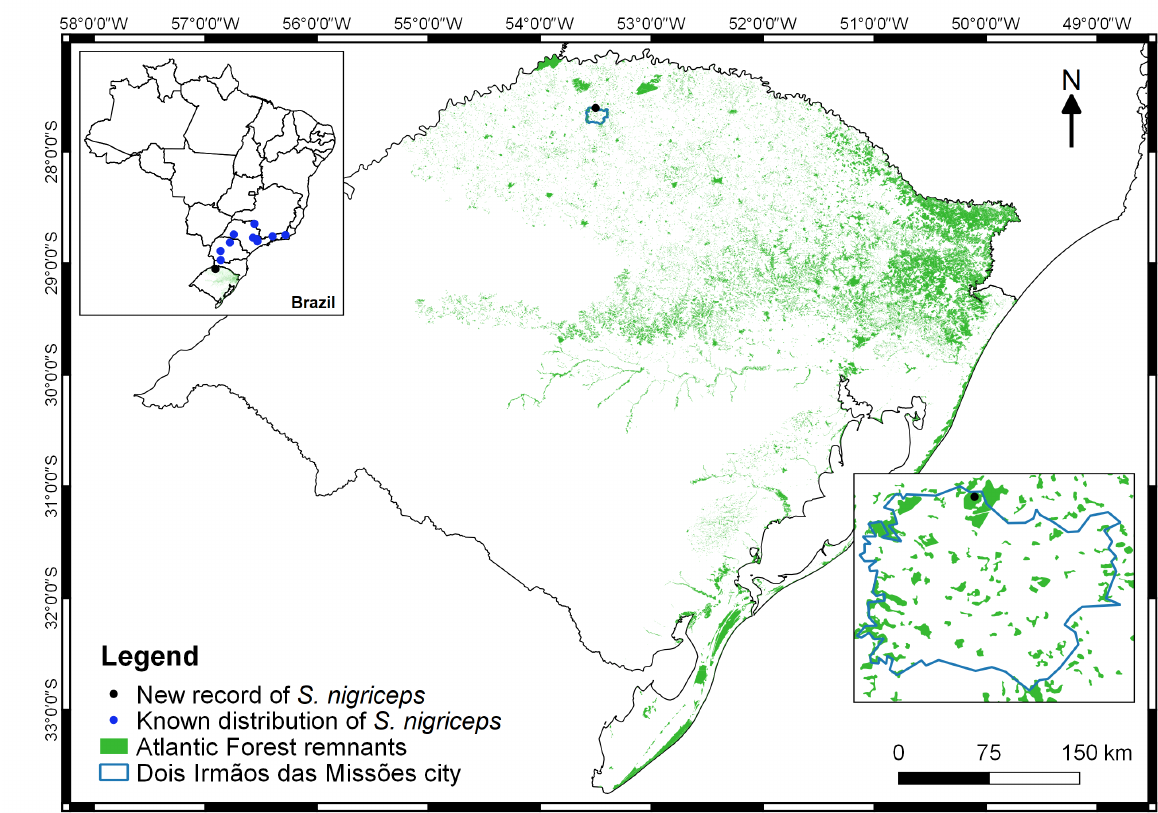
Figure 1 - Moreno Fortes Biological Reserve located in the municipality of Dois Irmãos das Missões, Rio Grande do Sul state,